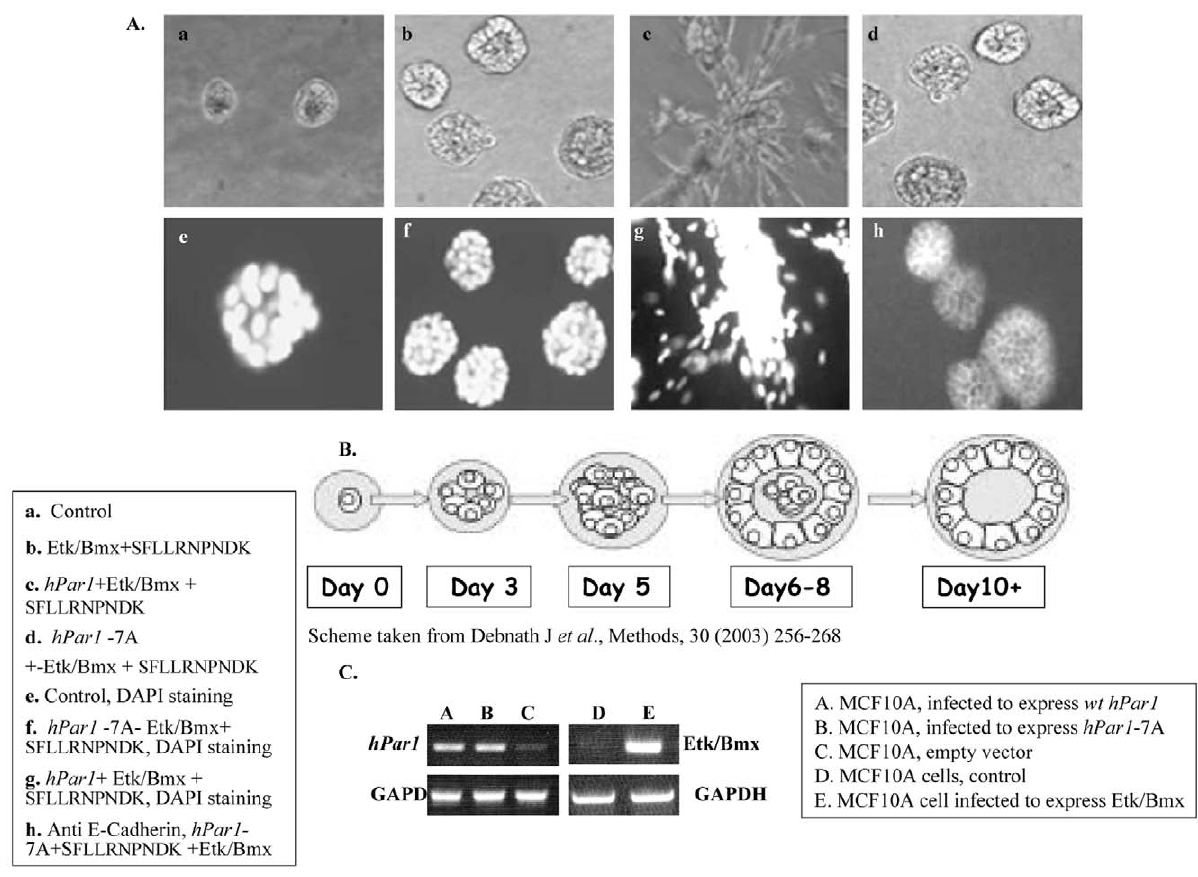
Figure 8. Morphogenesis of MCF10A spheroids infected with either wthPar1 , mutant hPar1-7A or with Etk/Bmx maintained in 3-D Matrigel cultures. A . Upper panel. Representative phase-contrast microscopic images of MCF10A cells under the following conditions: a. control untreated MCF10A. b. MCF10A cells infected with Etk/Bmx and SFLLRNPNDK PAR 1 -activated. c. MCF10A cells infected with both wt hPar1 and Etk/ Bmx and SFLLRNPNDK-activated. d. MCF10A cells infected with both mutant hPar1-7A and Etk/Bmx and SFLLRNPNDK-activated. Lower panel. Representative confocal microscopic images of MCF10A acini. e. Control untreated MCF10A, DAPI stained nuclei in a representative spheroid. f. MCF10A cells infected with both the mutant hPar1-7A and Etk/Bmx and SFLLRNPNDK-activated; DAPI staining of spheroid nuclei. g. MCF10A cells infected with both the wt hPar1 and Etk/Bmx and SFLLRNPNDK-activated; DAPI staining of the nuclei. h. MCF10A cells infected with both the mutant hPar1-7A and Etk/Bmx and SFLLRNPNDK-activated, stained for cell-cell contact with anti-E-cadherin. B . Schematic representation of MCF10A spheroid development in 3-D Matrigel cultures. C . RT-PCR analyses for the different MCF10A-infected cells. Levels of expression as compared to those of a house-keeping gene (GAPDH). A. MCF10A-infected wt hPar1 B. MCF10A infected with mutant hPar1 - 7A . C. Empty vector infected-MCF10A cells. D. Control, untreated MCF10A cells. E. MCF10A cells infected with Etk/Bmx.